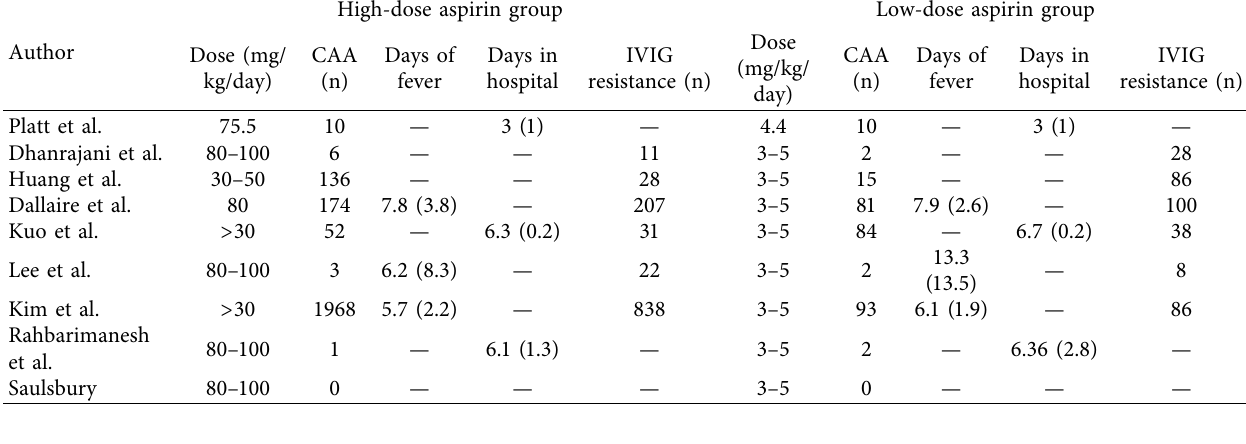
Table 2: Comparison between high-dose and low-dose aspirin groups.